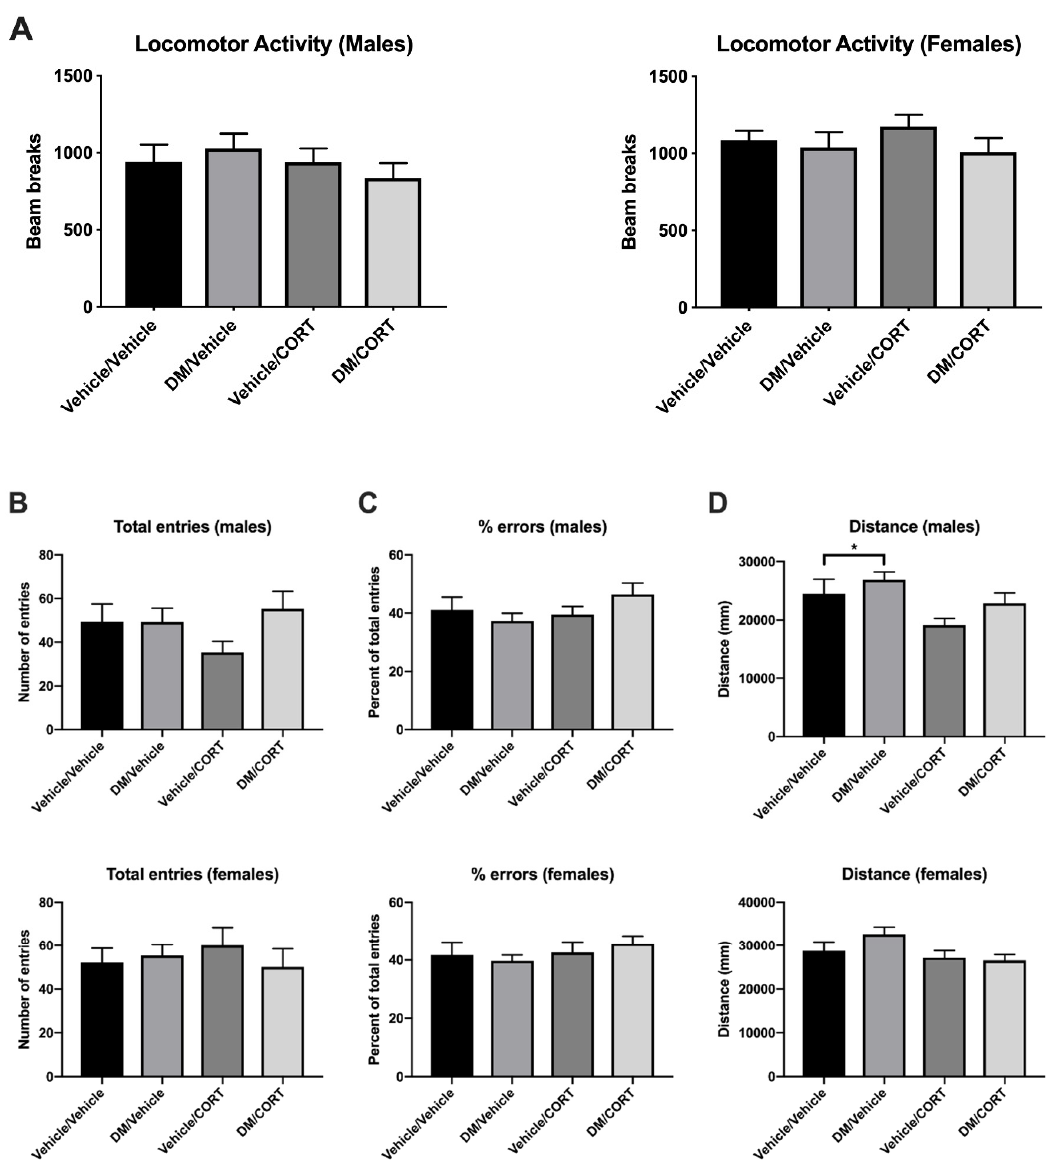
Figure 7. Males exposed to deltamethrin (DM) only exhibited increased distance traveled in the Y maze, but there were no significant di ff erences in locomotor activity and Y maze attention performance in males and females exposed to DM, corticosterone (CORT), or both. Locomotor activity and Y maze assays were conducted in male and female o ff spring exposed to one of four treatment groups at 8 weeks of age. In ( A ) data are expressed as the average number of beam breaks in 60 min after a 30-min habituation period. In ( B – D ) mice were allowed to freely explore the Y maze for 8 min and arm entries were recorded to assess working memory, attention, and total distance traveled. Exposure group di ff erences were assessed via one-way ANOVA with Tukey’s post-hoc analyses and stratified by sex. * p < 0.05, N = 7–9, and error bars represent